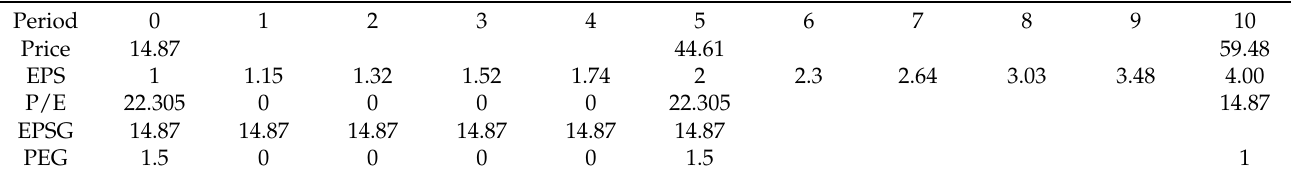
Table 4. Price Growth Rate is Higher Than Earnings Growth Rate in the First 5 Years.